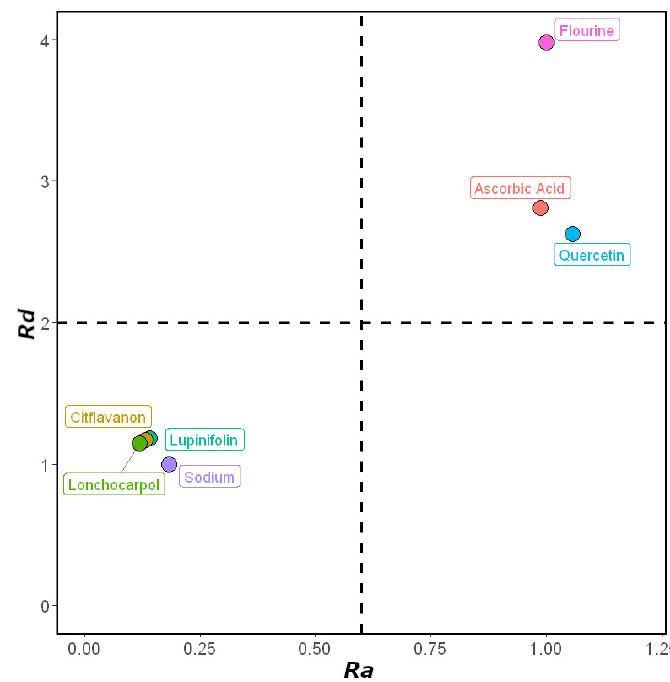
Figure 3. DAM of flavanones ( 1–3 ) and reference compounds (Table S1).